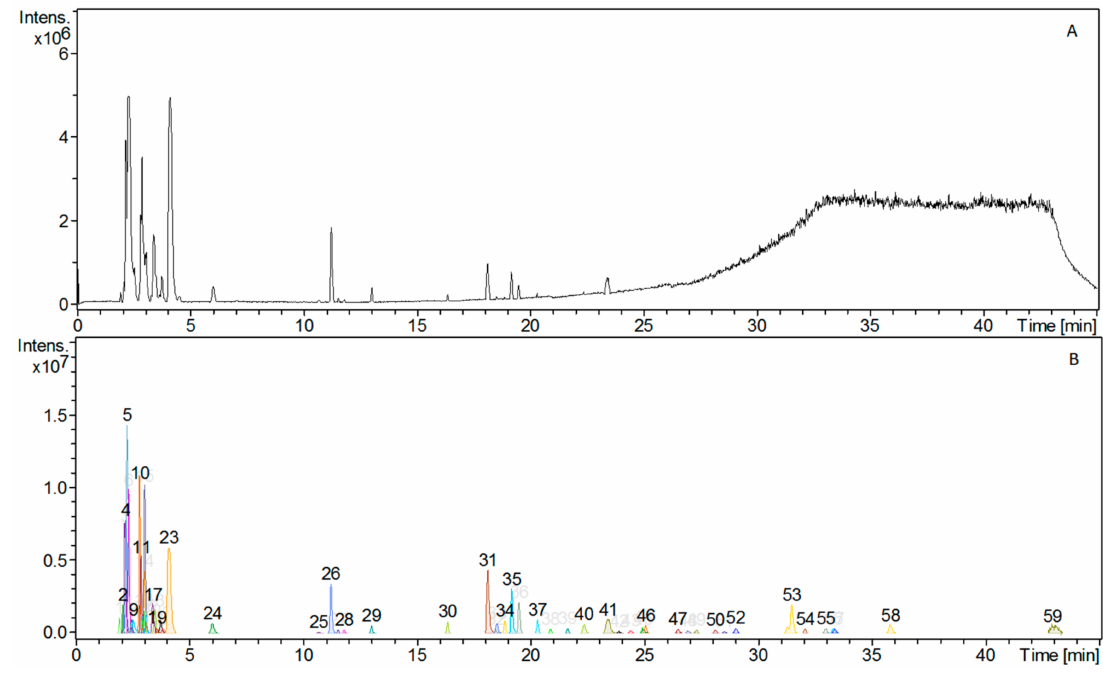
Figure 1. The Amaranthus caudatus ( AC ) extract consists of a complex mixture of phytochemicals. A high pressure liquid chromatography (HPLC) chromatogram with ( A ) total ion current (TIC) chromatogram and ( B ) processed chromatogram showing the presence of at least 59 different peaks each corresponding to a compound with a discrete molecular weight. From the retention time and protonated molecular ions [M + H] + from the MS spectra, some peaks corresponding to amino acids were assigned: Peak 18, iso-leucine